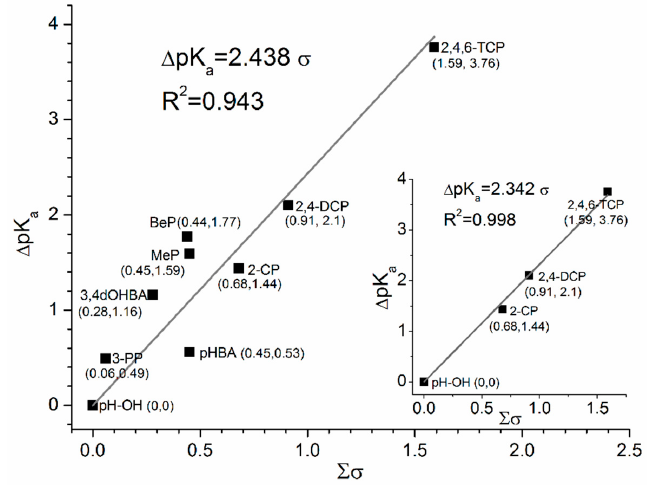
Figure 7. Hammett plot for phenolic compounds.